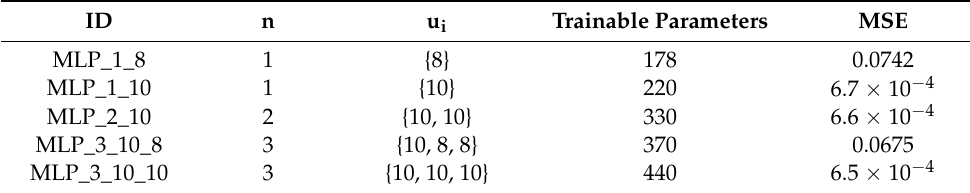
Table 3. The list of evaluated network topologies, described by the number of hidden layers n and the neurons in each layer u i , and the mean squared errors (MSE) produced by their predictions in the validation dataset. The IDs contain the number of hidden layers and the number of neurons of the first hidden layer, or two firsts hidden layers for the case where the first is equal.